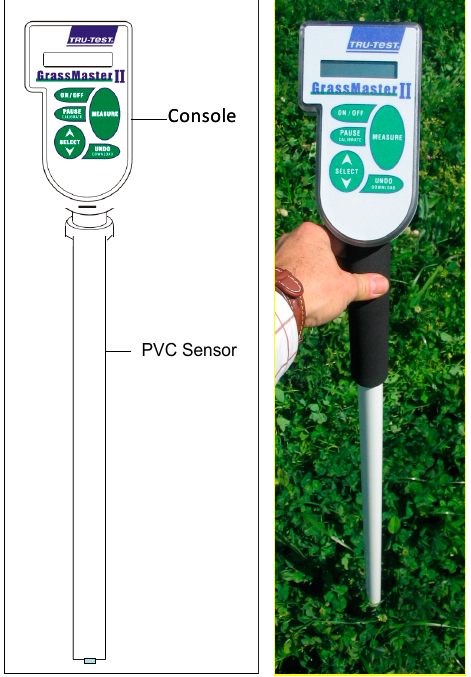
Figure 2. Grassmaster II: electronic interface (console) and probe (PVC Sensor).